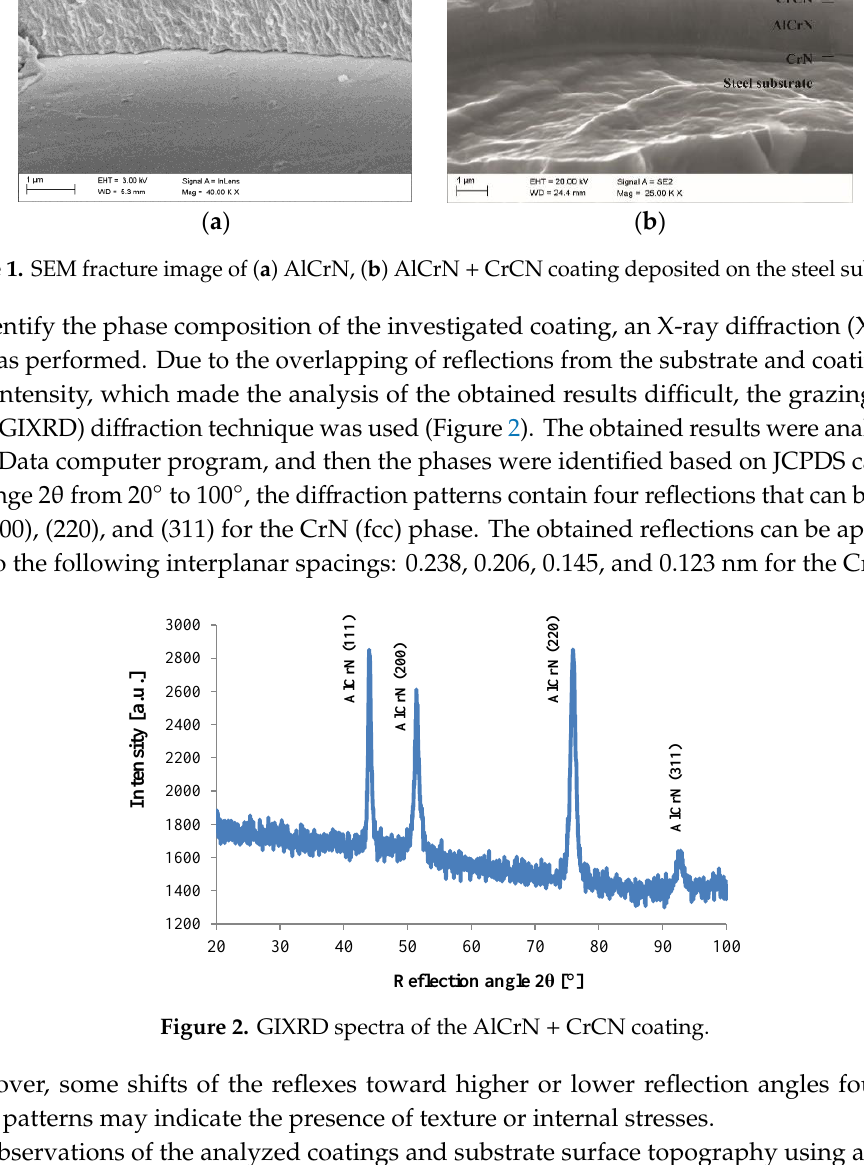
Figure 2. GIXRD spectra of the AlCrN + CrCN coating.